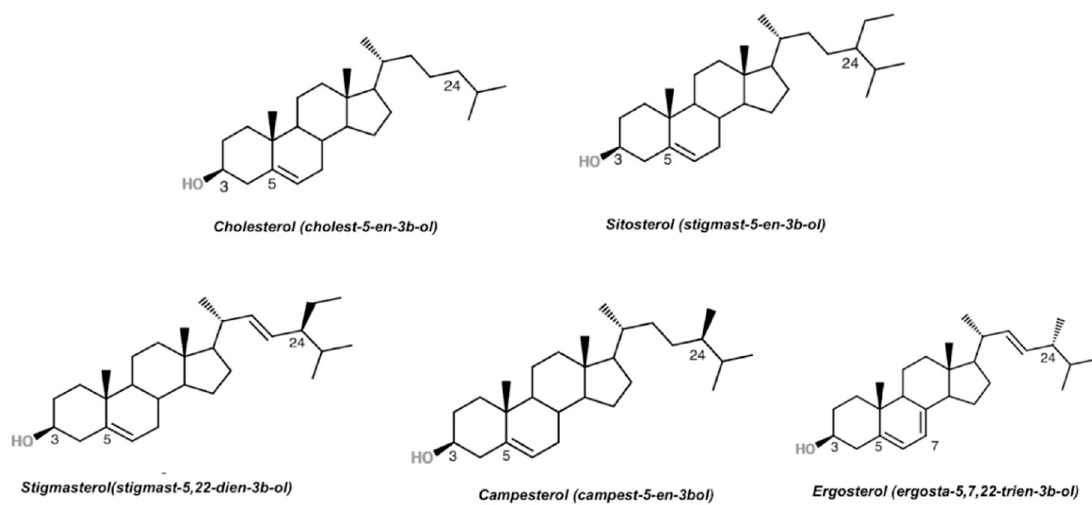
Figure 1. Chemical structures of cholesterol and plant sterols (sitosterol, stigmasterol, campesterol, and ergosterol).